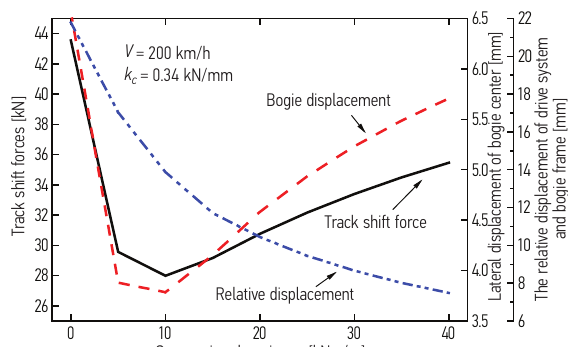
Fig. 25. The simulation results of locomotive 2 when the k c is 0.34 kN/mm